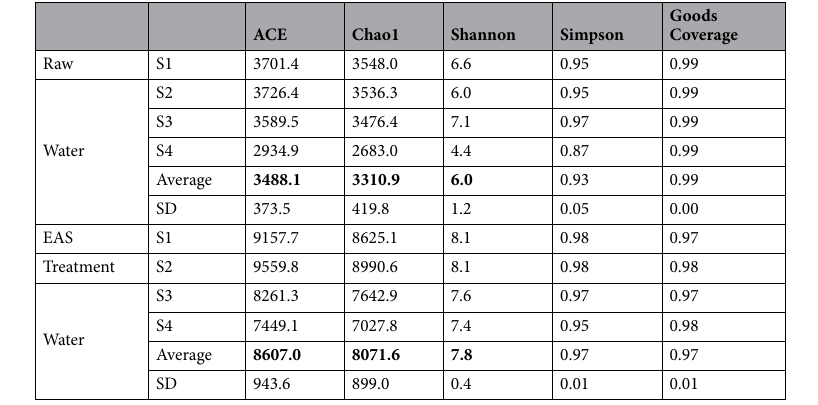
Table 1. Comparison of diversity index of microbial community in study water body before and after 30 days’ EAS